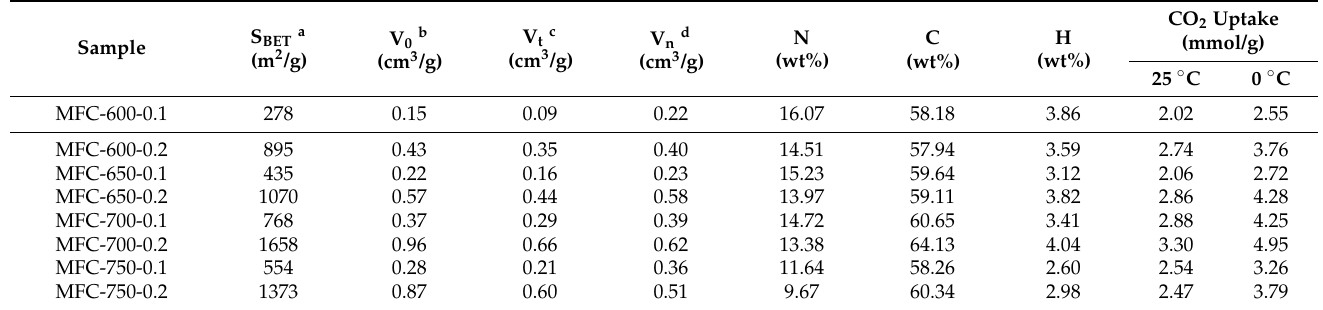
Table 1. Porous textural, elemental compositions, and CO 2 uptakes of adsorbents derived from melamine formaldehyde resin under different conditions.